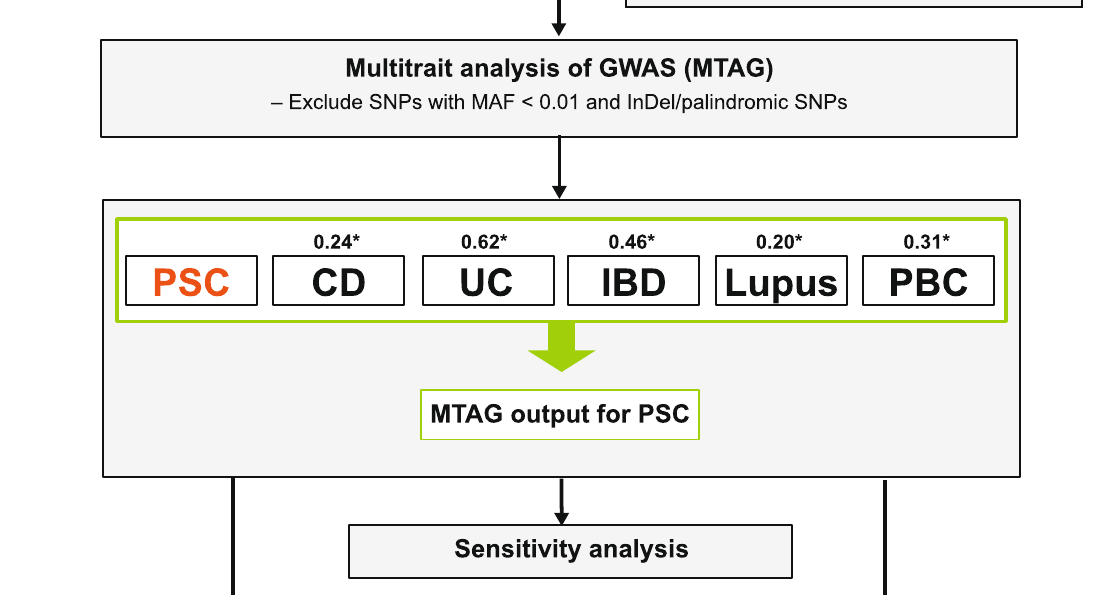
complexregion.Theasterisk “ * ” indicatesthegeneticcorrelationbetweenPSCand each tested trait. The imputed summary statistics for PBC were used for sub- sequent